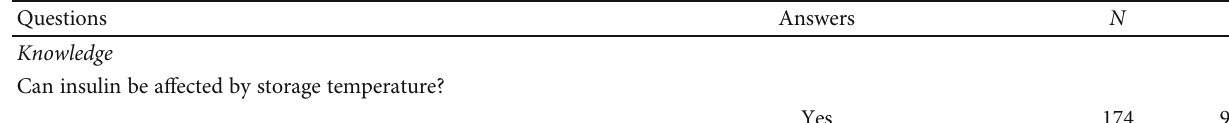
Table 2: Insulin knowledge and practice among diabetic